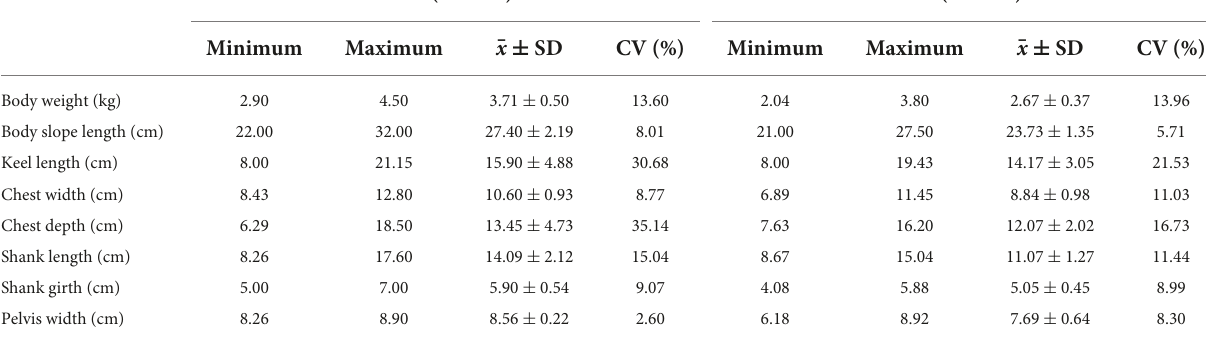
TABLE 1 body and weight measurements of adult Anjian chickens.